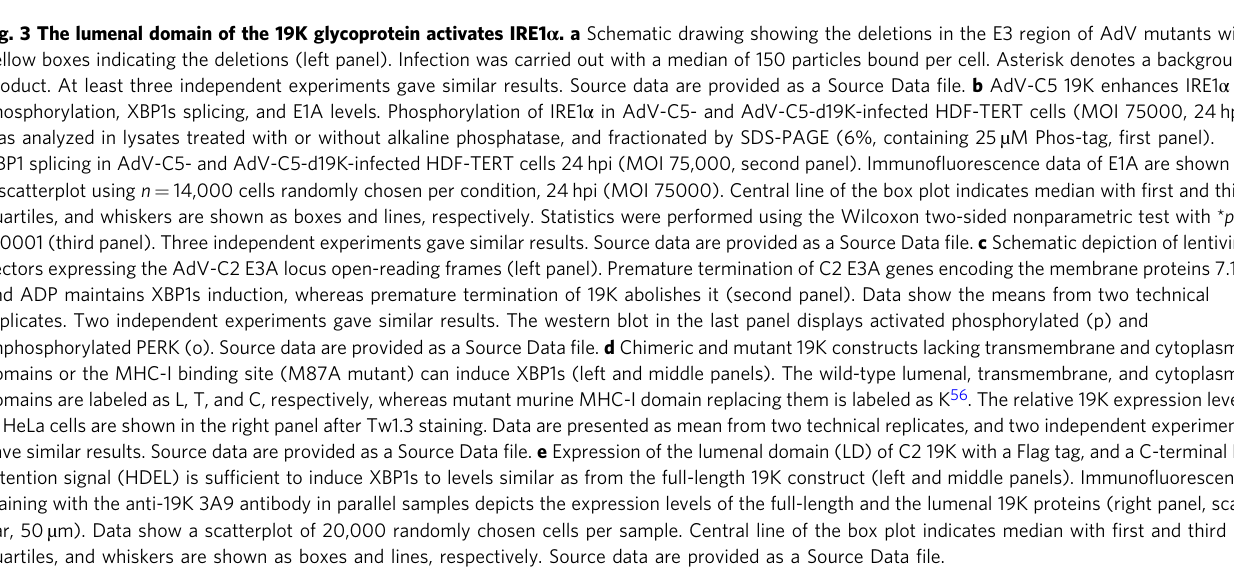
Fig. 3 The lumenal domain of the 19K glycoprotein activates IRE1 α . a Schematic drawing showing the deletions in the E3 region of AdV mutants with yellow boxes indicating the deletions (left panel). Infection was carried out with a median of 150 particles bound per cell. Asterisk denotes a background product. At least three independent experiments gave similar results. Source data are provided as a Source Data fi le. b AdV-C5 19K enhances IRE1 α phosphorylation, XBP1s splicing, and E1A levels. Phosphorylation of IRE1 α in AdV-C5- and AdV-C5-d19K-infected HDF-TERT cells (MOI 75000, 24